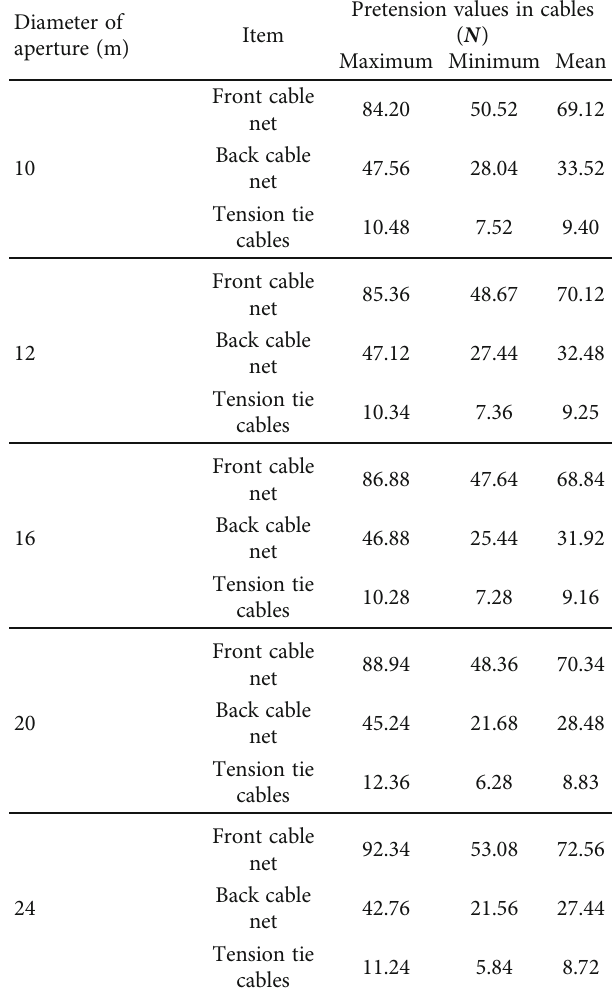
Table 2: Pretension distribution of the cable net with di ff erent aperture